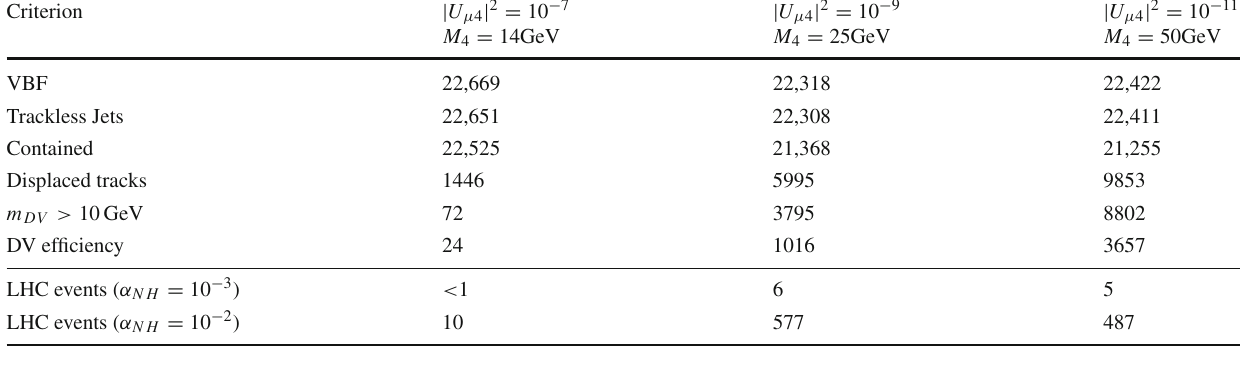
Table 7 As in Table 6, but for the extended model. On the last two rows we show the number of events expected at the LHC for two values of α NH